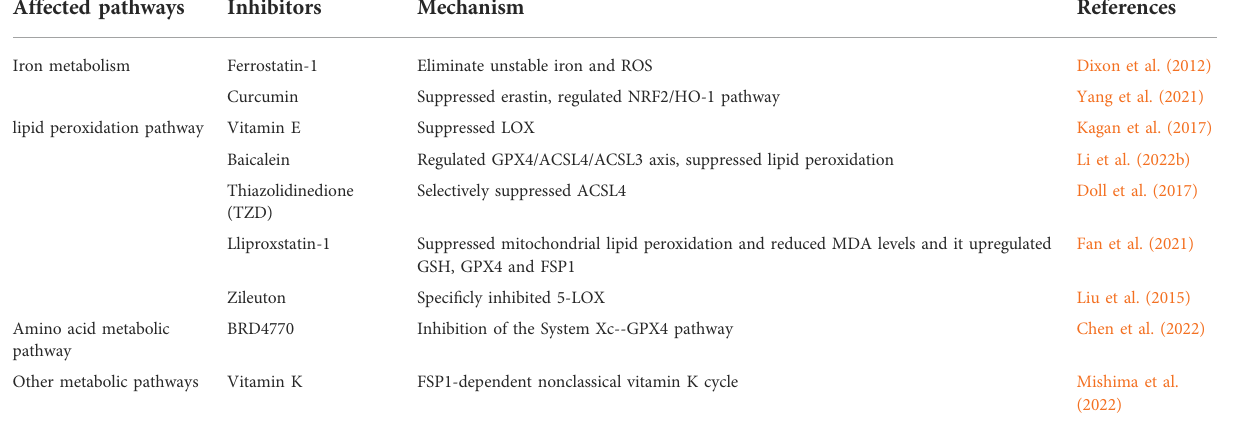
TABLE 2 The ferroptosis